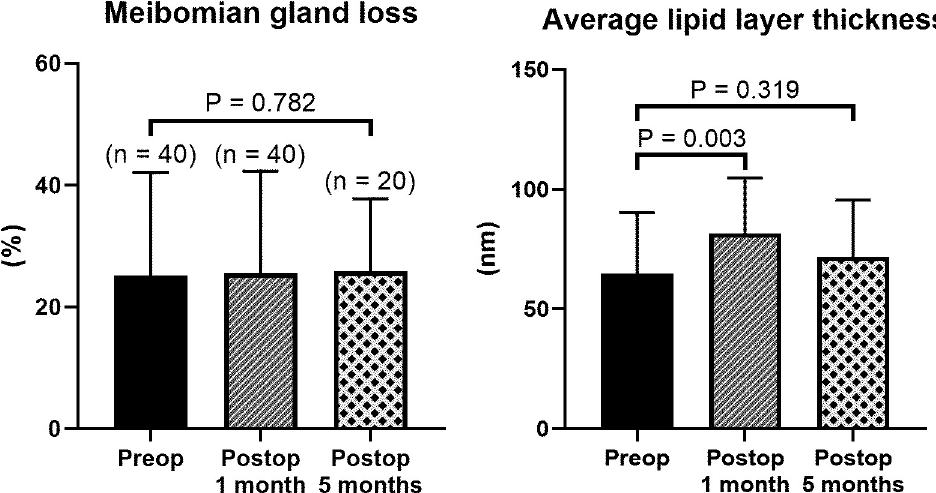
Fig 3. Changes of meibomian gland loss and average lipid layer thickness after surgery for marginal entropion. Meibomian gland loss at 1 and 5 months after surgery remained unchanged from preoperative meibomian gland loss (24.2% vs. 23.0% at 1 month and 24.2% at 5 months after surgery, respectively, all P > 0.05). Average lipid layer thickness increased after surgery (63 nm vs. 97 nm at 1 month and 75 nm at 5 months after surgery, respectively) with statistical significance at 1 month after surgery (P =